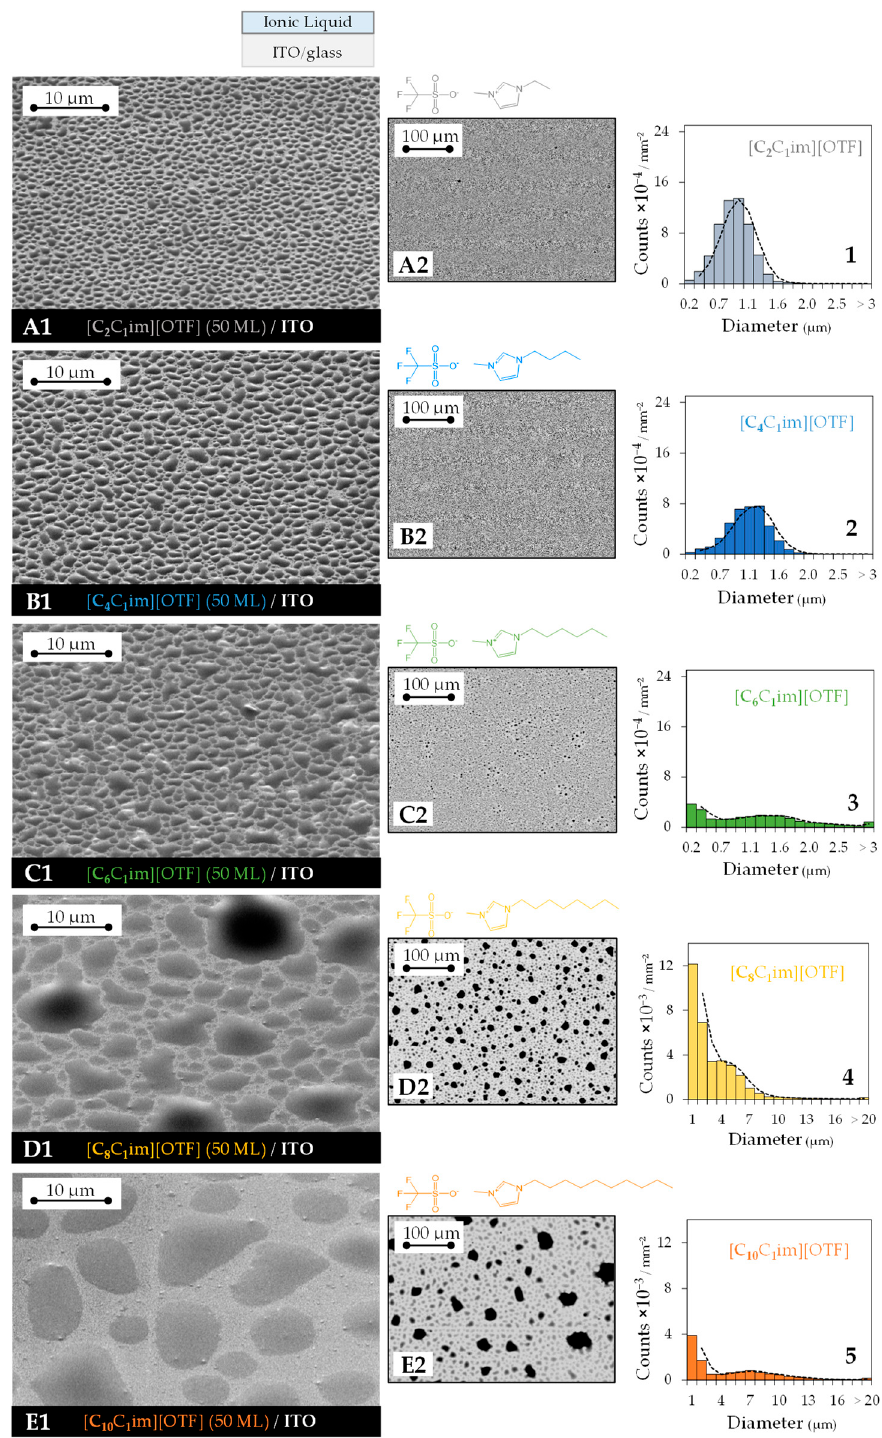
Figure 2. Micrographs acquired through high-resolution scanning electron microscopy of thin ionic liquid films (50 monolayers, ML) of [C 2 C 1 im][OTF] ( A1 , A2 ), [C 4 C 1 im][OTF] ( B1 , B2 ), [C 6 C 1 im][OTF] ( C1 , C2 ), [C 8 C 1 im][OTF] ( D1 , D2 ), and [C 10 C 1 im][OTF] ( E1 , E2 ) deposited onto surfaces of ITO/glass. Lateral views at 45° (magnification of 5000×) obtained by secondary electron imaging ( A1 – E1 ) and top views (magnification of 500×) obtained by backscattered electron imaging ( A2 – E2 ). The histograms (inserts 1, 2, 3, 4, and 5) present the droplet´s size distribution for each sample.